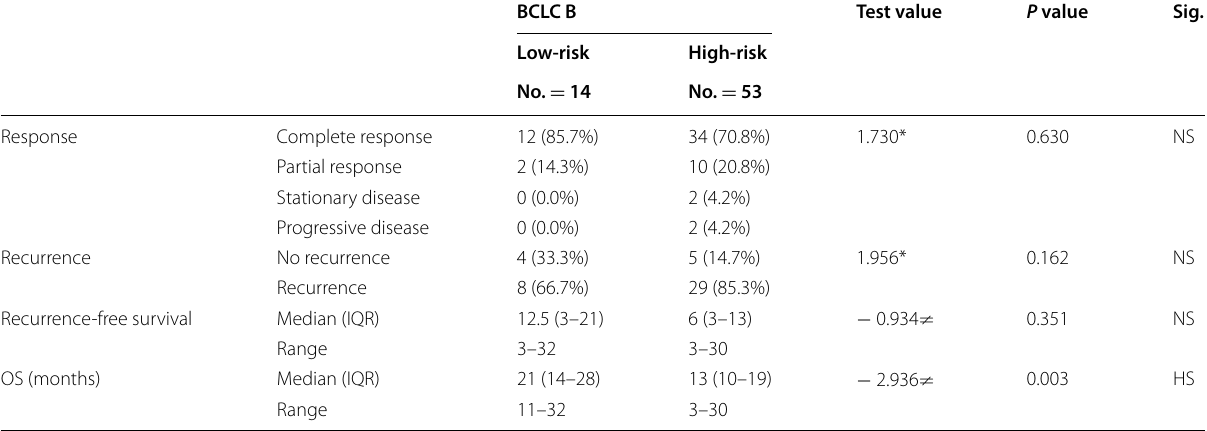
Table 10 Classifying BCLC B cases into low- and high-risk groups for TACE according to the AFP